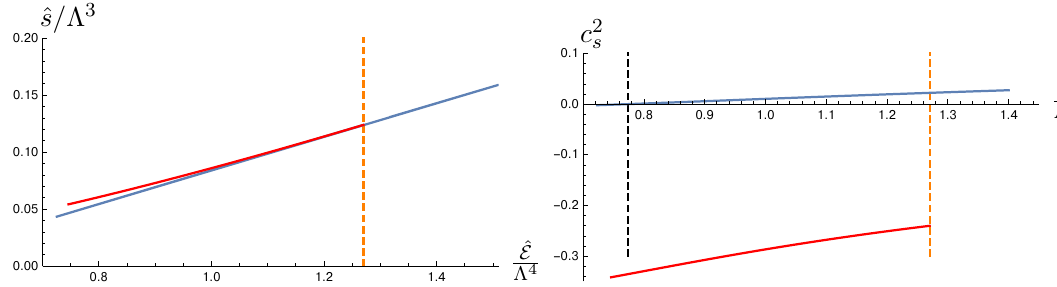
Figure 2 . Phase diagram of the cascading gauge theory plasma in microcanonical ensemble. Solid blue lines represent deconfined, chirally symmetric phase of the theory — the gravitational dual to these thermal states is a Klebanov-Tseytlin black hole. Solid red lines represent deconfined phase of the theory with the spontaneously broken chiral symmetry — the gravitational dual to these thermal states is a Klebanov-Strassler black hole. Left panel shows the entropy density versus the energy density of the symmetric and the symmetry broken phases. The vertical dashed orange line indicates the onset of the perturbative instability of the chirally symmetric phase; the vertical dashed black line indicates the onset of the instability of the sound waves in chirally symmetric phase of the cascading plasma. Right panel shows the speed of sound waves squared in symmetric and symmetry broken phases of the cascading